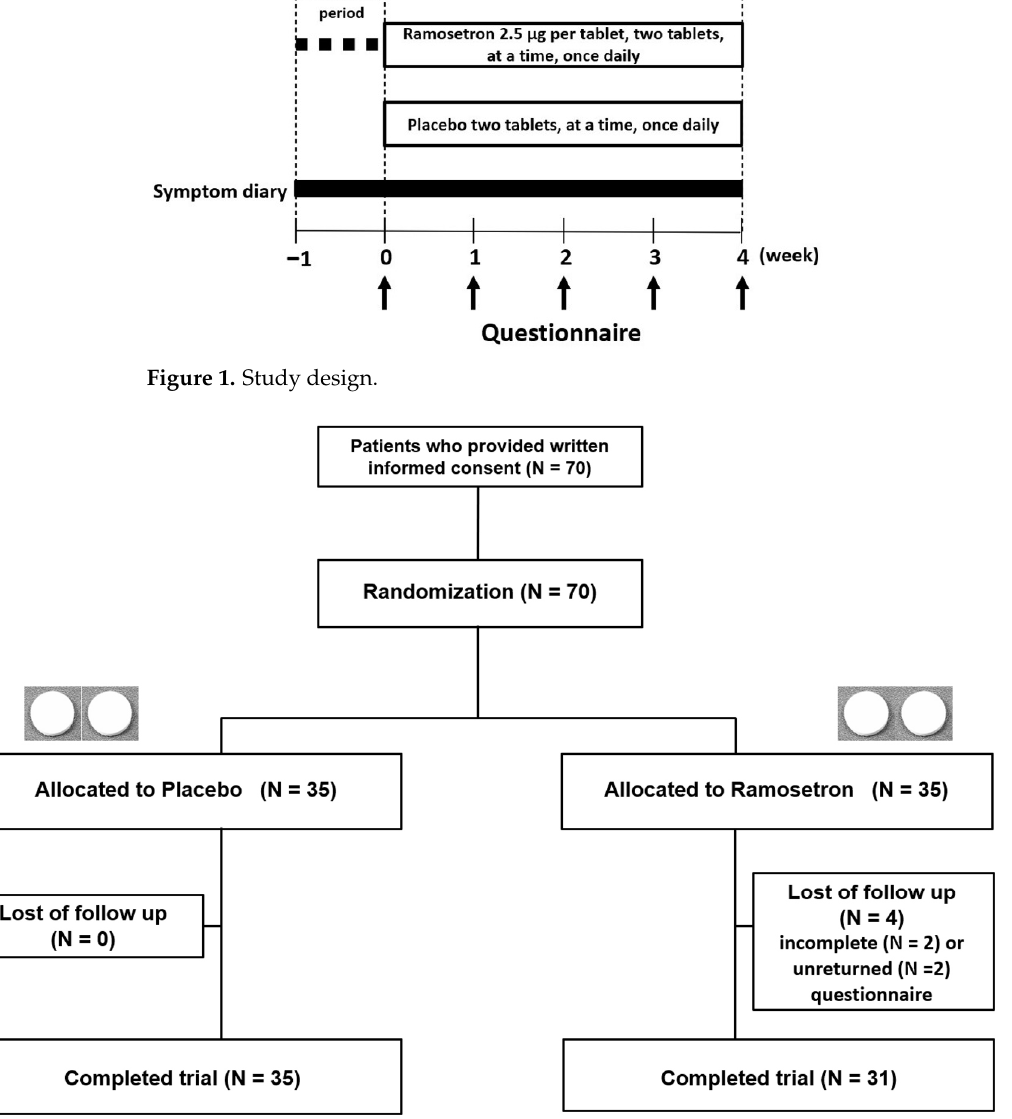
Figure 2. Flowchart of patients throughout the study period. Details of patients who dropped out are shown.